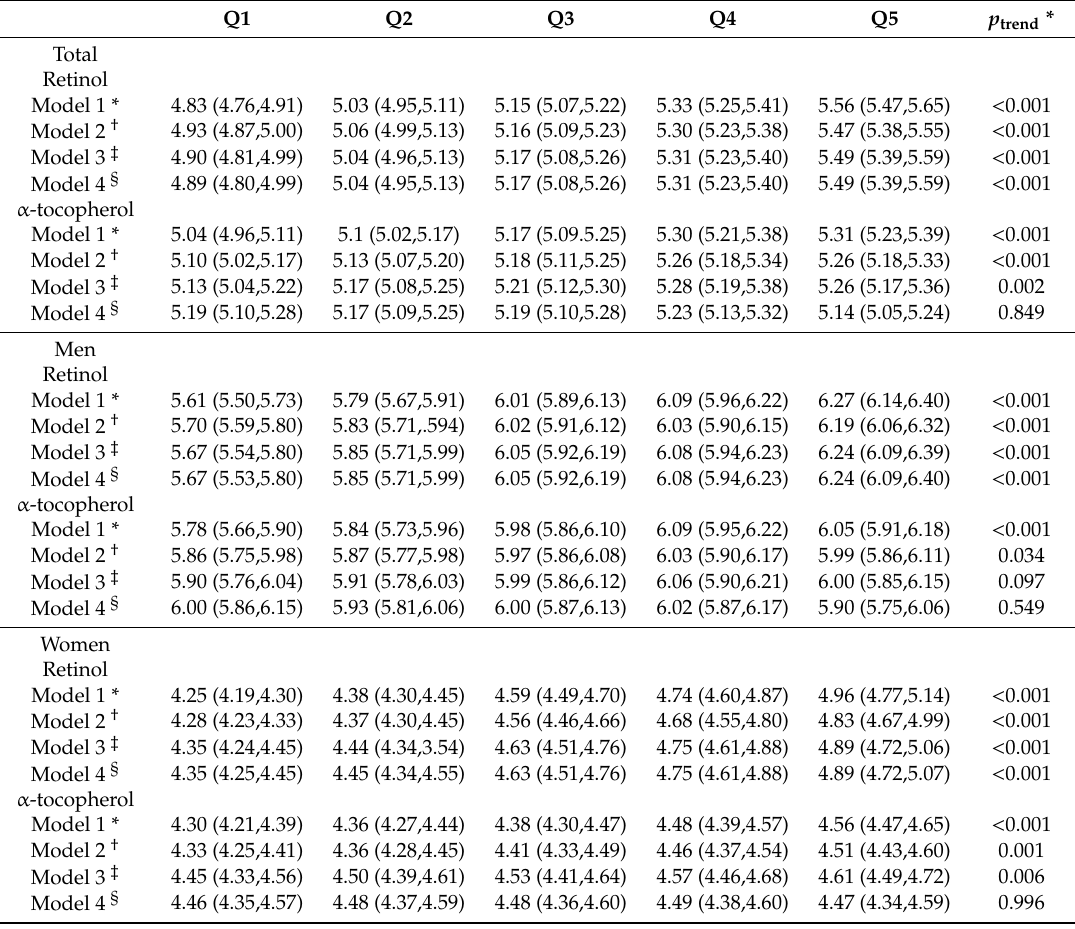
Table 2. Association of serum retinol and α -tocopherol concentration with uric acid levels. Q1 Q2 Q3 Q4 Q5 p trend